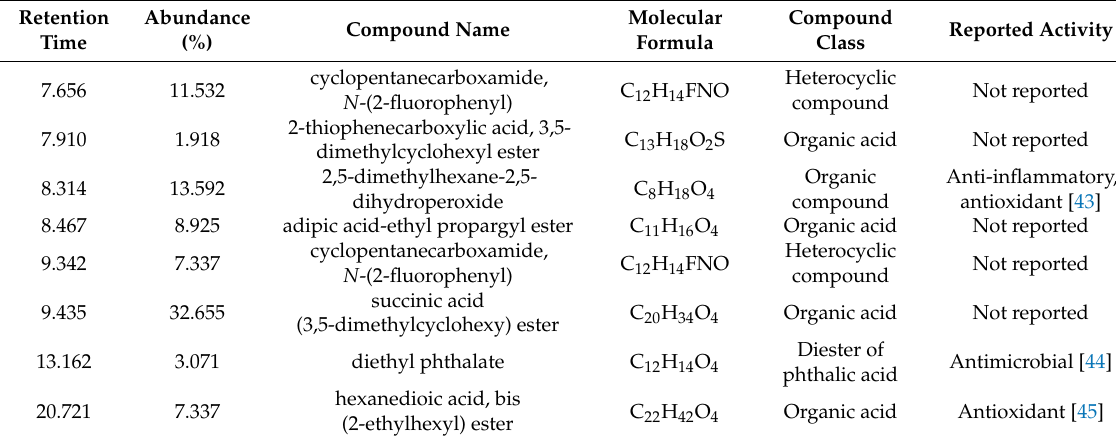
Table 3. Active compounds identified in the ethyl acetate fraction of Nyctanthes arbor-tristis aqueous flower extract by gas chromatography / mass spectrometry (GC / MS)